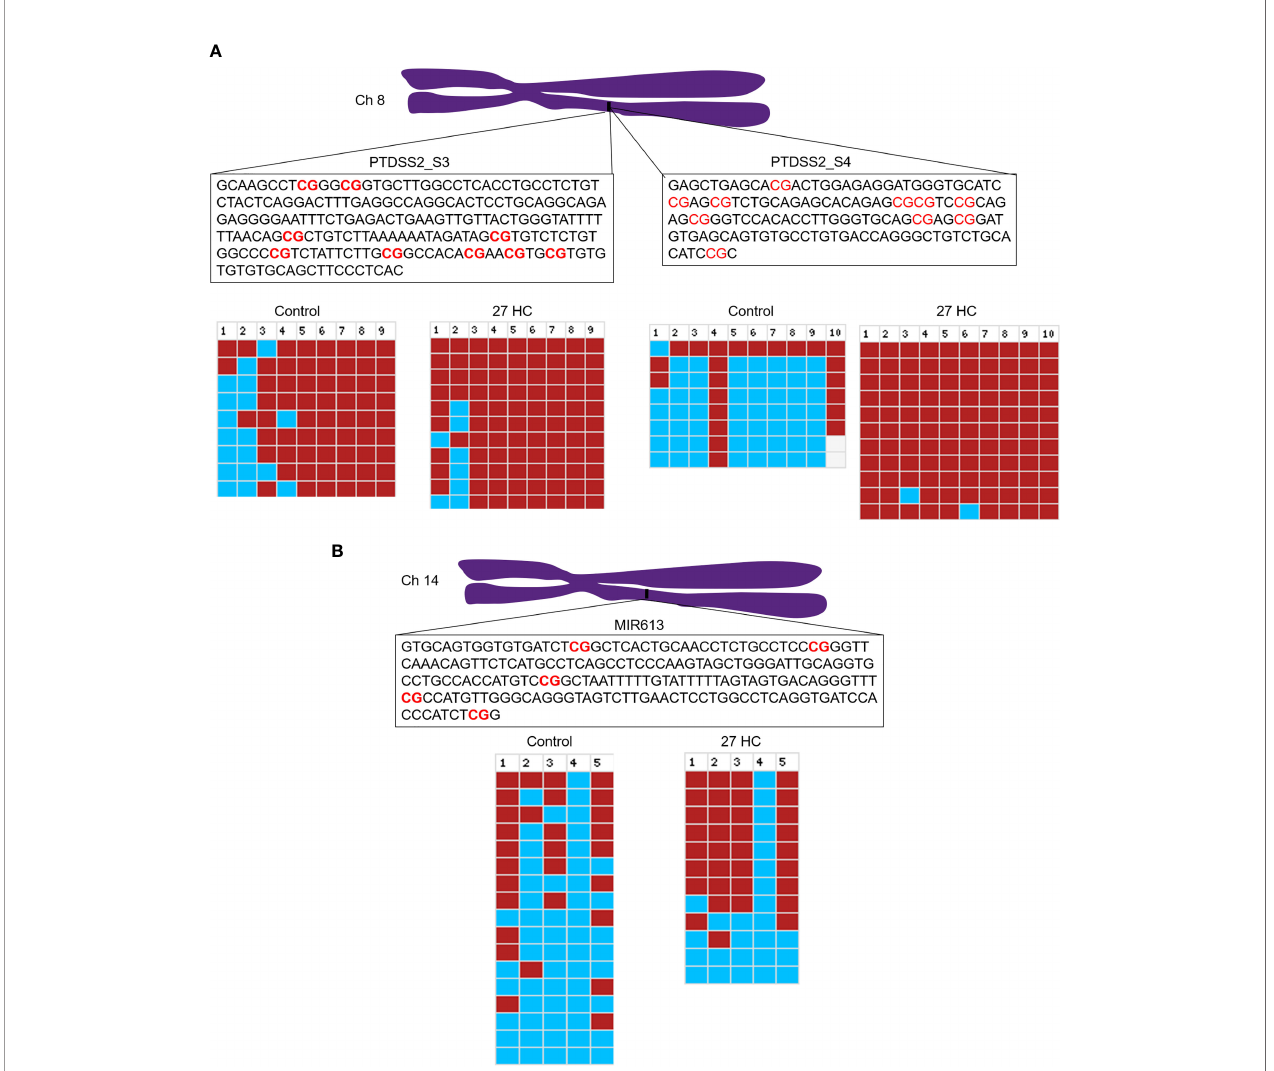
FIGURE 3 | Validation of promoter DNA methylation by bisul fi te sequencing: (A) Schematic representation of PTDSS2 promoter region in the chromosome 8, and the boxes contain the sequences of two amplicons from PTDSS2 gene promoter. The CpGs are highlighted in red. In the bisul fi te sequencing analysis output from BISMA, the red box indicates methylated CpGs and the blue box indicates the unmethylated CpGs. Increased methylation is observed at the CpG 1, CpG 2, and CpG 3 in the PTDSS2 amplicon 1 of 27-HC-treated cells than DMSO control. There is signi fi cantly increased methylation at the amplicon 2 in 27-HC-treated cells than DMSO control. Each row indicates individual clone, and the number at the top indicates the CpG sites of the corresponding amplicons. (B) The bisul fi te sequencing analysis for mir613 and location of its position on chromosome 14. The box contains the sequence of amplicon from the mir613 promoter, and the CpG sites are highlighted in red. There is a signi fi cant level of hypermethylation at the CpG 2, 3, and 5 in 27-HC-treated cells than DMSO control. Each row indicates individual clone, and the number at the top indicates the CpG sites of the corresponding